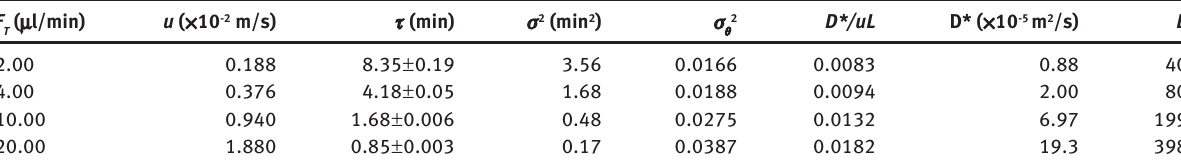
Table 4 Comparison of dispersion for single-phase RTDs at different flow